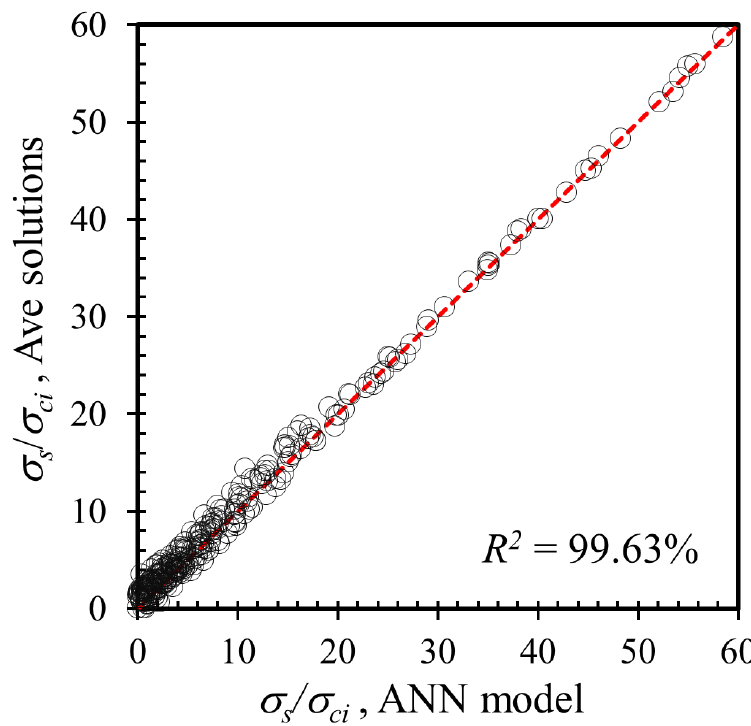
Figure 15. Comparison between FELA solution and predicted value from ANN model. Table 3. Performance measures of each methodology.